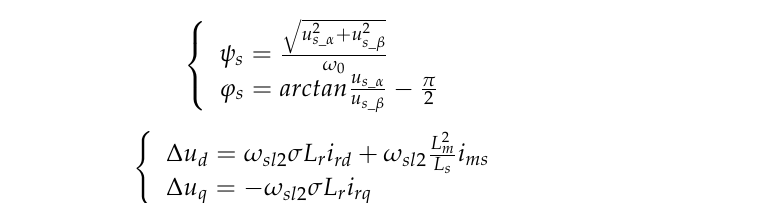
i.e., ω sl 2 = ω − ω r . u s _ α and u s _ β are the components of the stator voltage in the αβ As shown in Equation (12), assuming that axis, d decreases as 0 J increases, which prevents the rate of frequency variation from